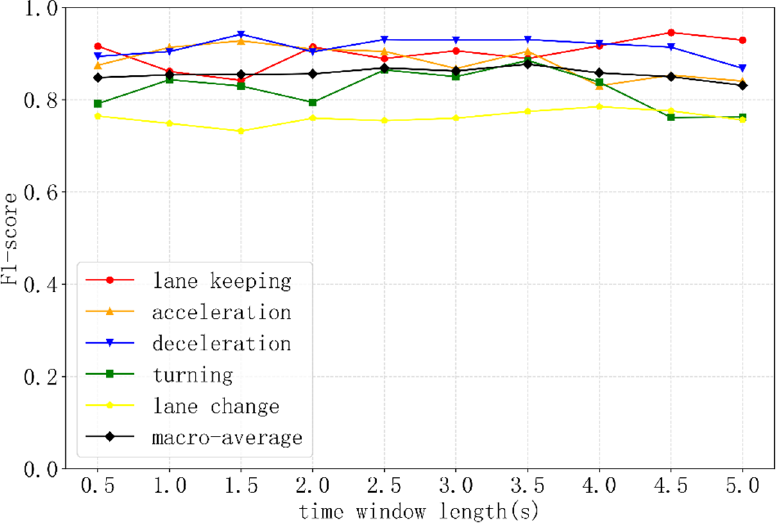
Figure 7. Identification results of different time windows.